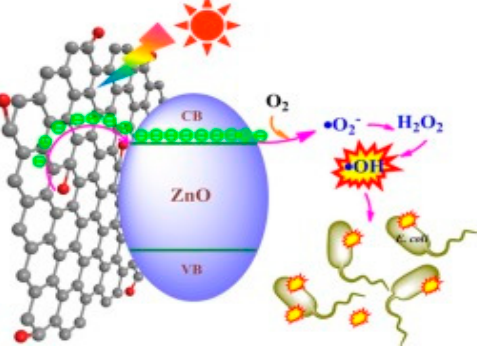
Figure 8. Electron transfer from graphene sheet to the conduction band of ZnO under visible light for generating ROS. Reproduced from [173] with permission of Elsevier.